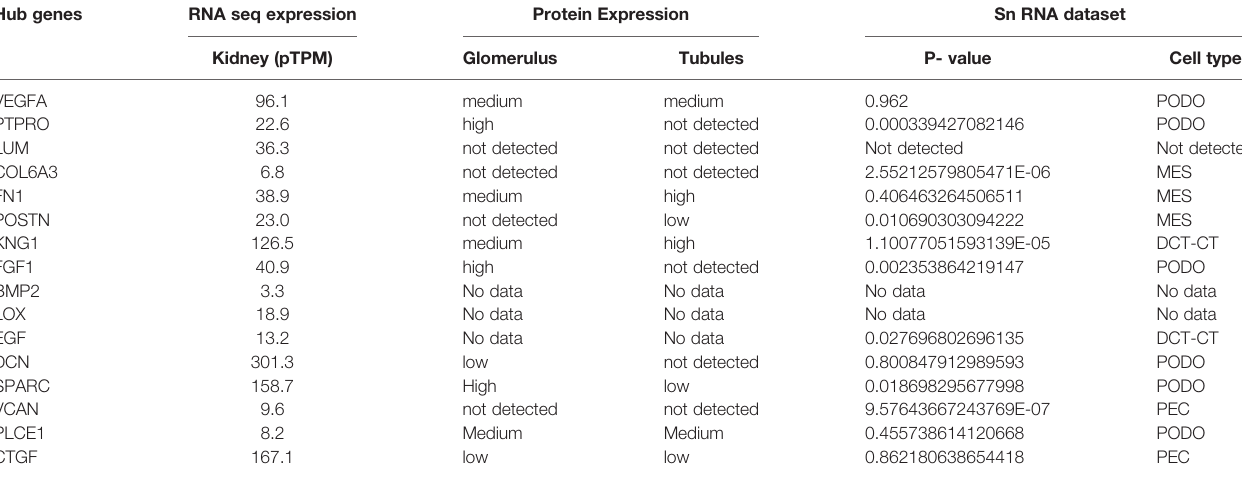
TABLE 2 | Expression levels of the hub genes identi fi ed from GTEx and HPA data. Hub genes RNA seq expression Protein Expression Sn RNA